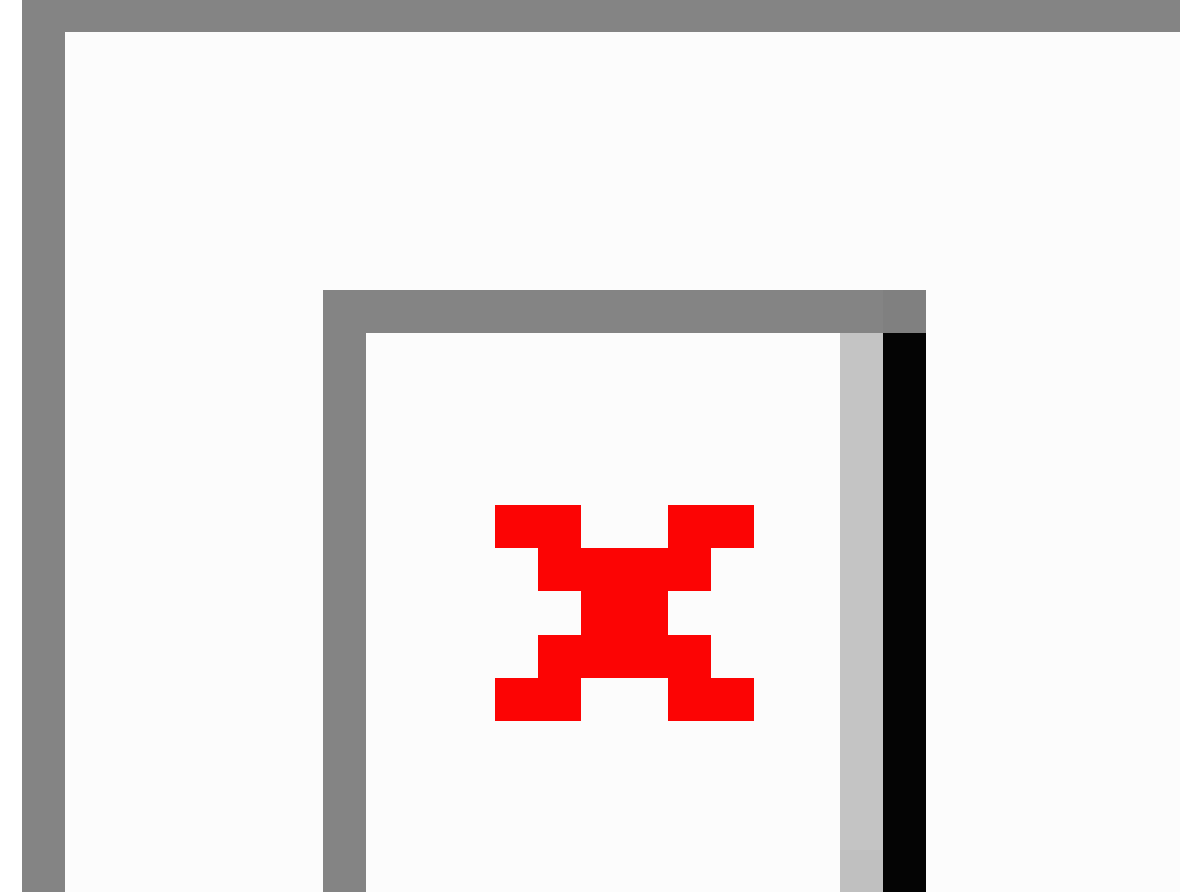
Figure 4. Distributions of (a) hospital (H) locations and (b) type 1 diabetes patients living in Ar Riyadh. The projection scale for these maps is